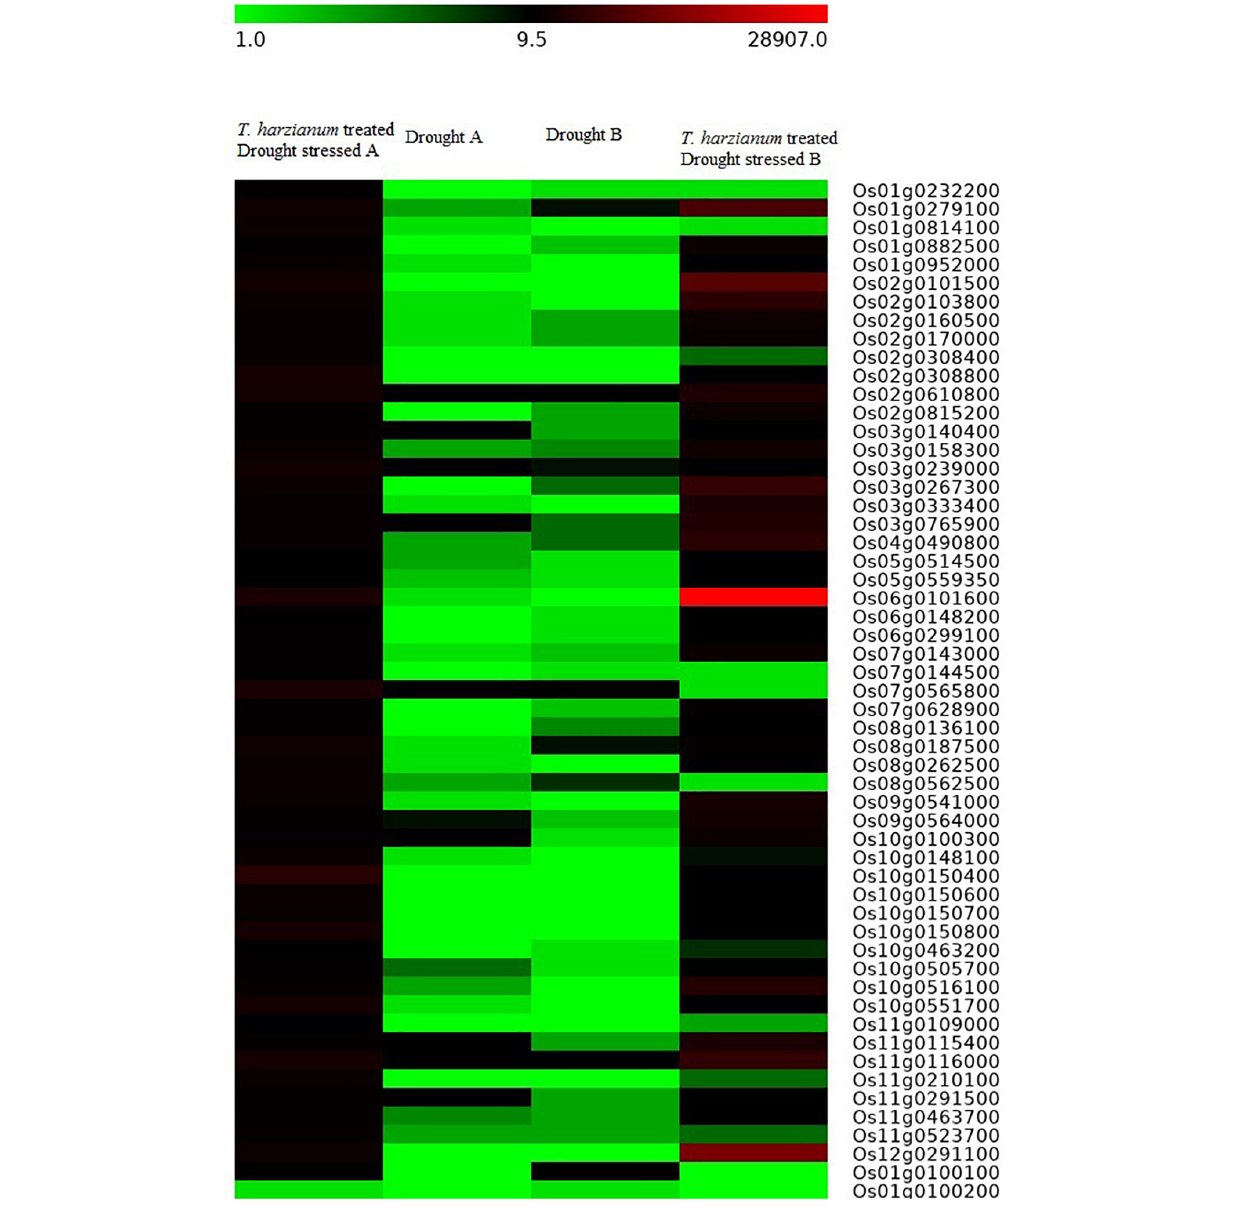
Frontiers in Microbiology |